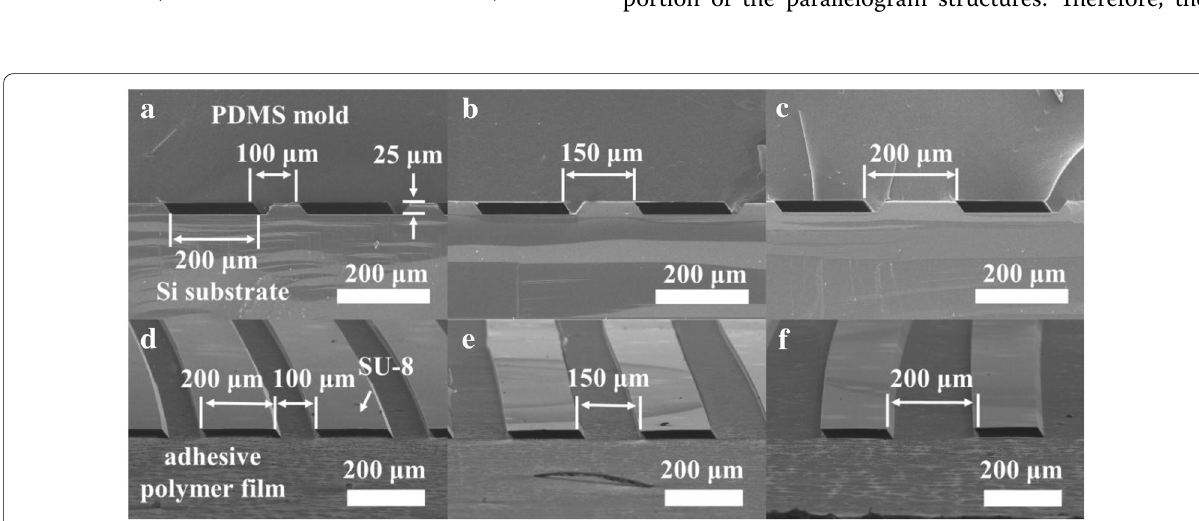
Fig. 4 SEM images of Type 2 specimen. a – c Aligned parallelogram channels, and d – f parallelogram structures on the adhesive polymer